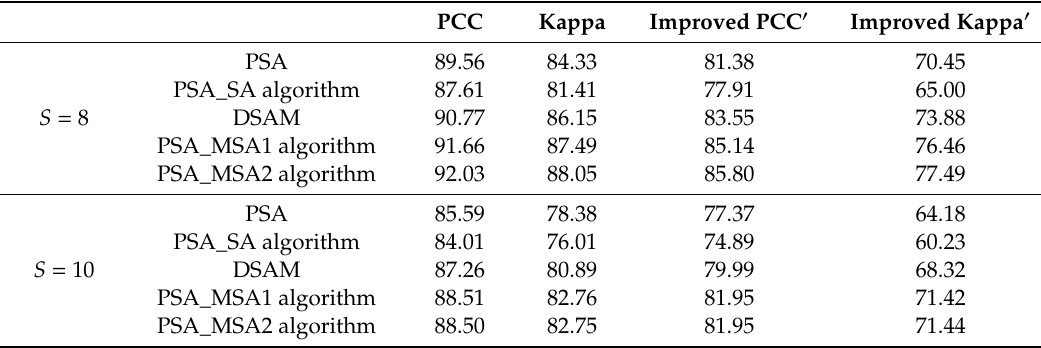
Table 5. Accuracy (%) results of di ff erent models for a real land image.